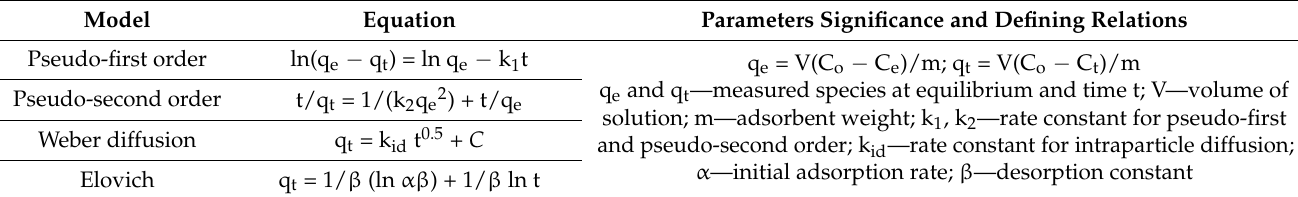
Table 3. Equations of the kinetic models applied in this